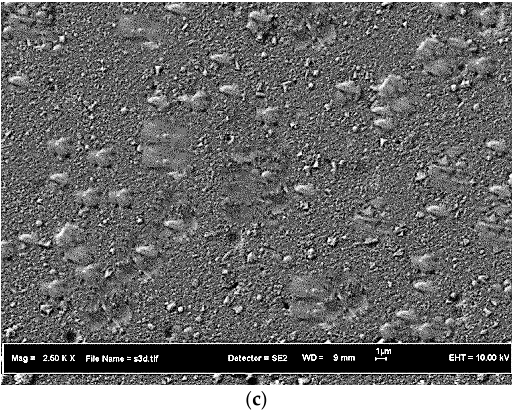
Figure 1. Surface morphology of TiN: ( a ) before ultrasonic treatment; ( b ) at 8 kHz; ( c ) at 16 kHz (ultrasonic treated for 5 min).